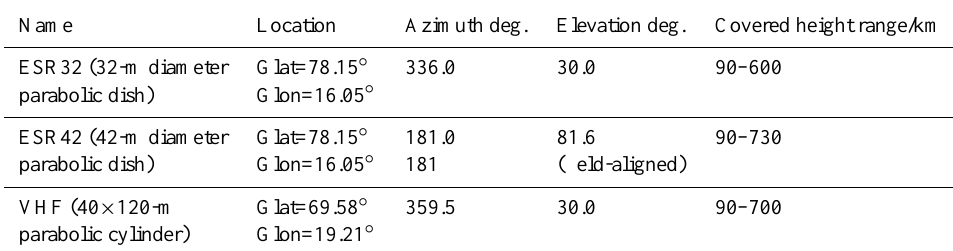
Table 1. Parameters of the EISCAT radars for the experiment on 21 February